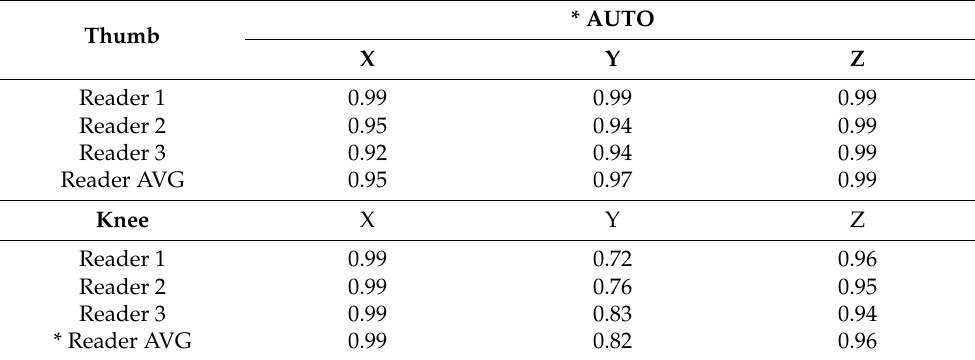
Figure 8. Bland Altman plots showing the limits of agreement between our proposed approach for kinematic parameter estimation (cardan angles) and a manual landmark identification (by three readers) approach for ( a ) thumb base; ( b ) knee. The mean of landmarks identified by the three readers is compared to our multi-atlas segmentation and landmark propagation approach. Shaded regions represent the limits of agreement of the three readers combined. Table 4. ICCs of cardan angles obtained by expert readers and by the proposed automated workflow (Auto) for the three axes for the thumb and knee.